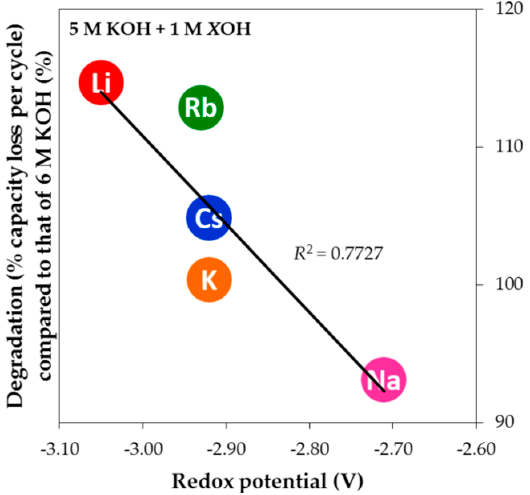
Figure 14. Plot of the degradation performances of 5 M KOH + 1 M X OH aqueous solutions normalized to that of 6 M KOH aqueous solution vs. the standard redox potentials of alkali elements X s.